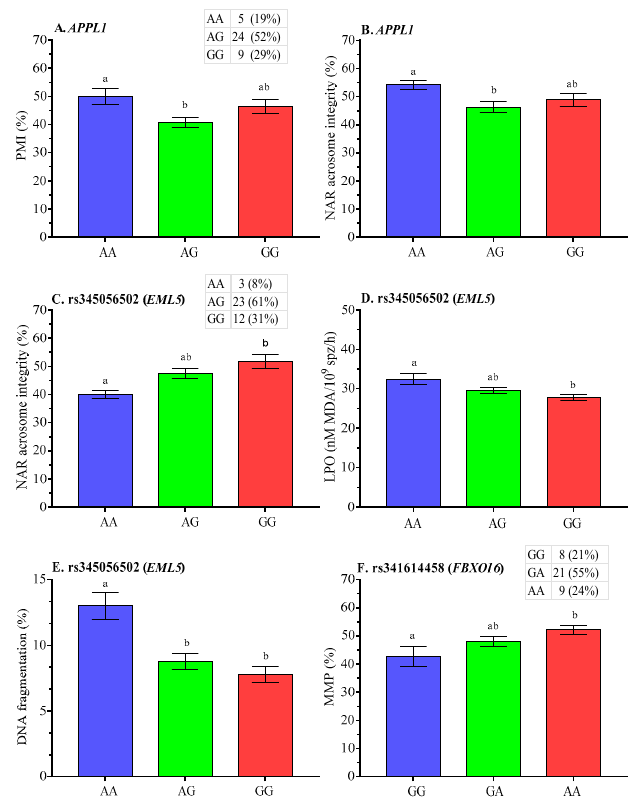
Figure 5. Effect of polymorphisms in A–B . APPL1 , C – E . EML5, and F . FBXO16 genes on post ‐ thaw membrane integrity of boar spermatozoa. Data are presented as the mean ± SEM. a,b Differences between genotypes were significantly different at p < 0.05.